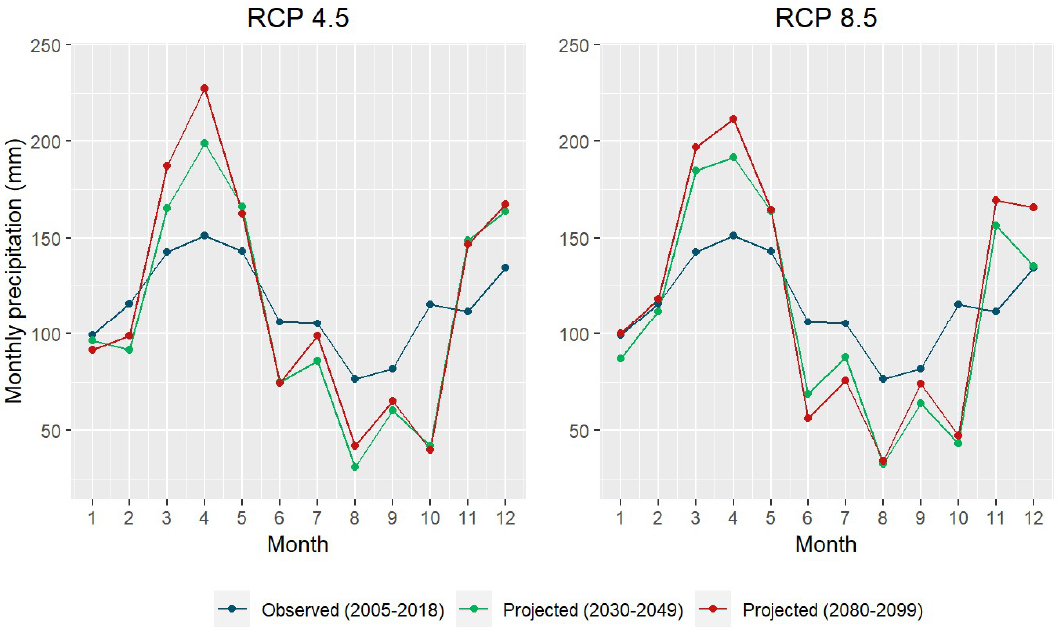
Figure 3. Monthly precipitation observed between 2005 and 2018 (blue) and projected for 2030–2049 (green) and 2080–2099 (red). The projected precipitation represents the average of precipitation projected by 32 global climate models under Representative Concentration Pathways (RCPs) 4.5 (left) and 8.5 (right).